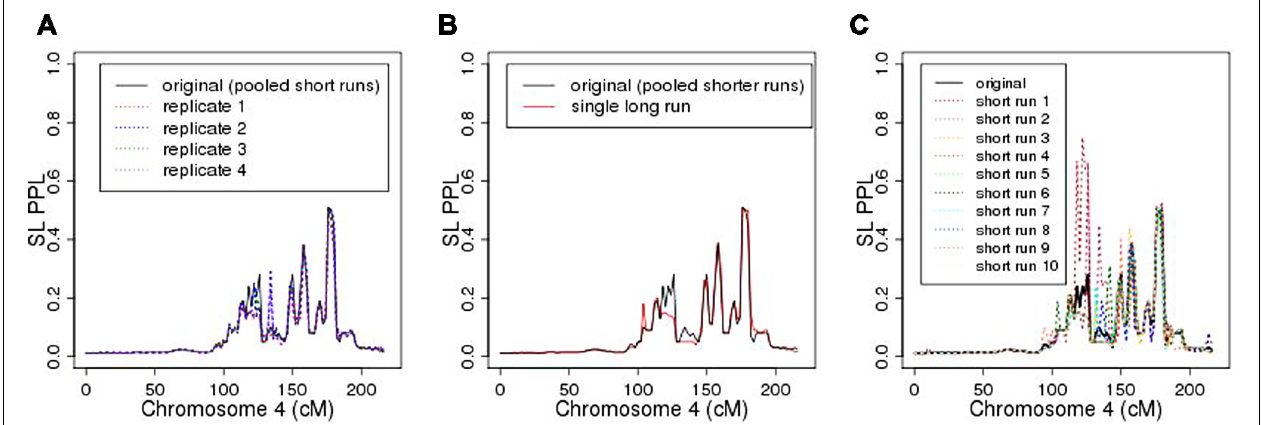
FIGURE 6 | (A) Five replicates of chromosome 4 analysis; (B) original analysis compared to single long sampling run; (C) original (averaged) analysis compared to individual component short runs.